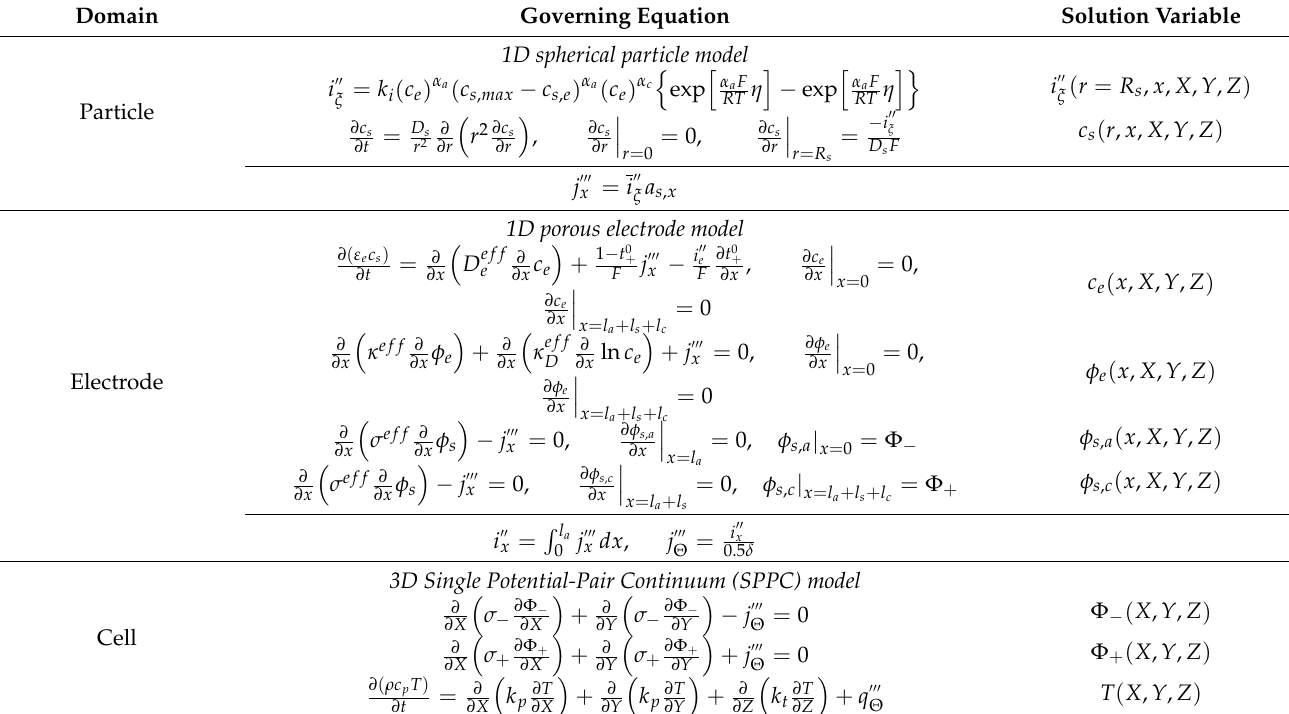
Table 1. Summary of solution variables and governing equations of the sub-models.